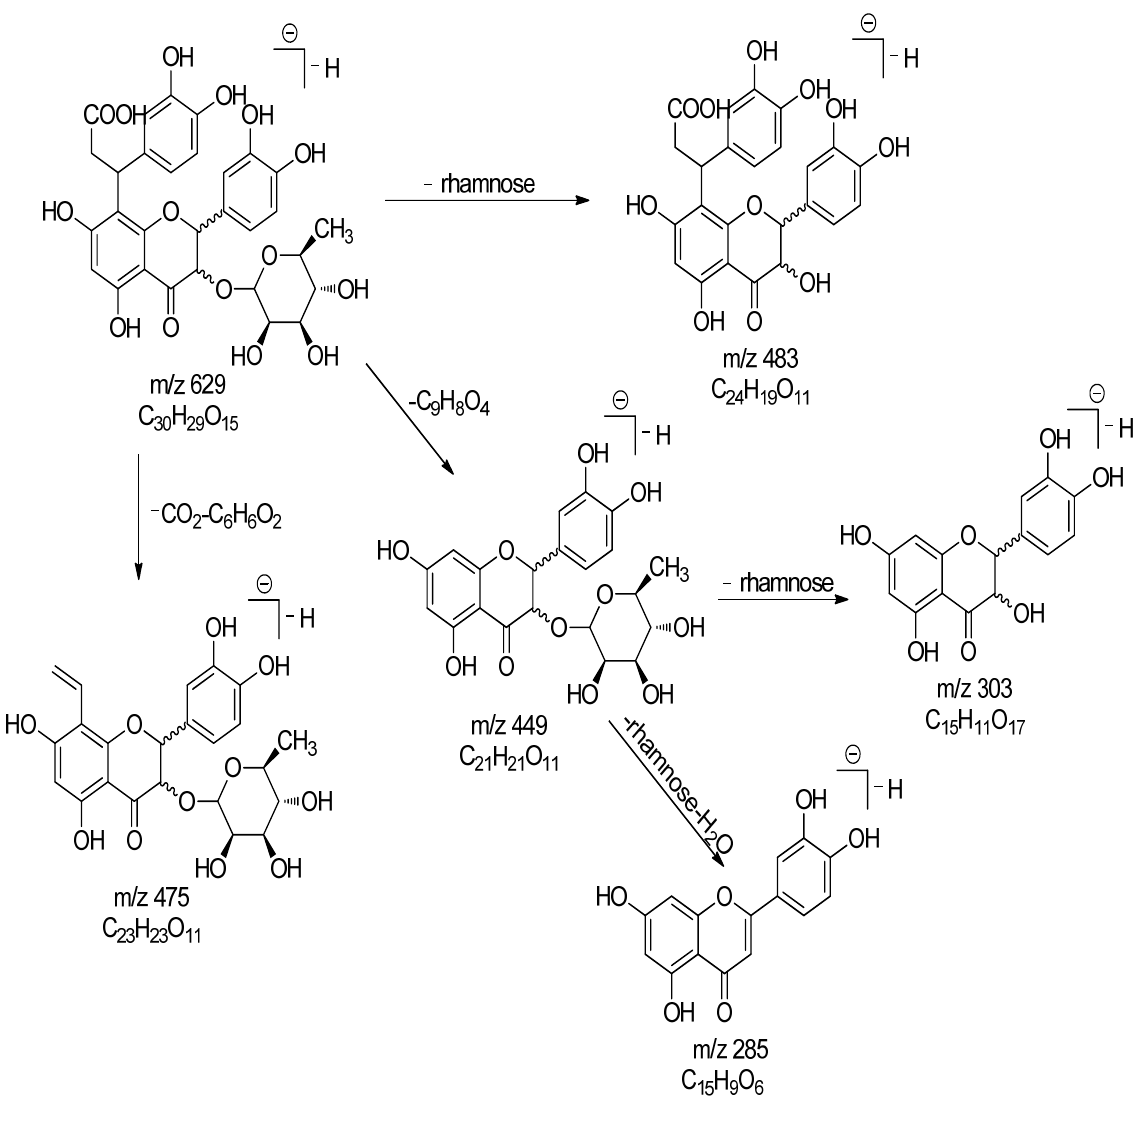
Figure 2. Proposed fragmentation pathways for compounds 19 , 21 , 25 and 29